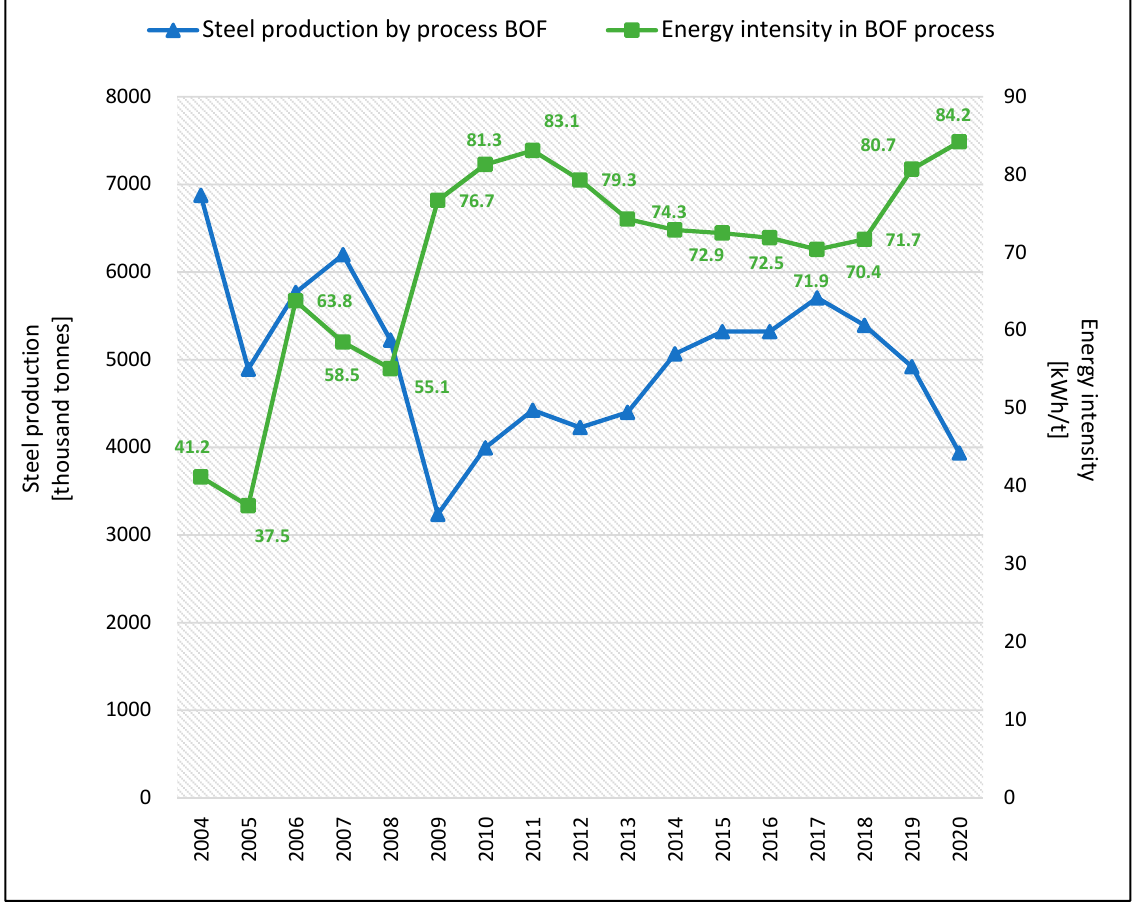
Figure 9. Energy intensity per 1 tonne of steel in the BOF process in Poland from 2004 to 2020. Source: Own elaboration based on data from [11].